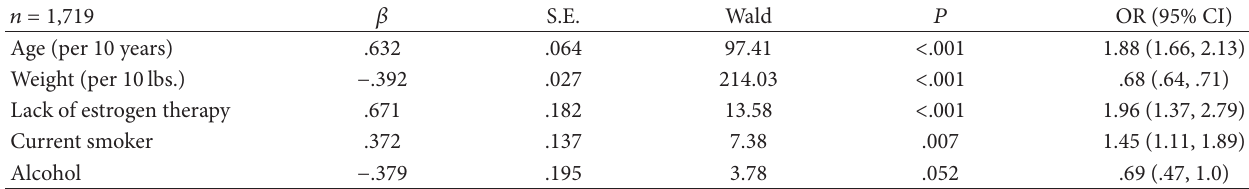
T 2: Reduced model logistic regression: white females,